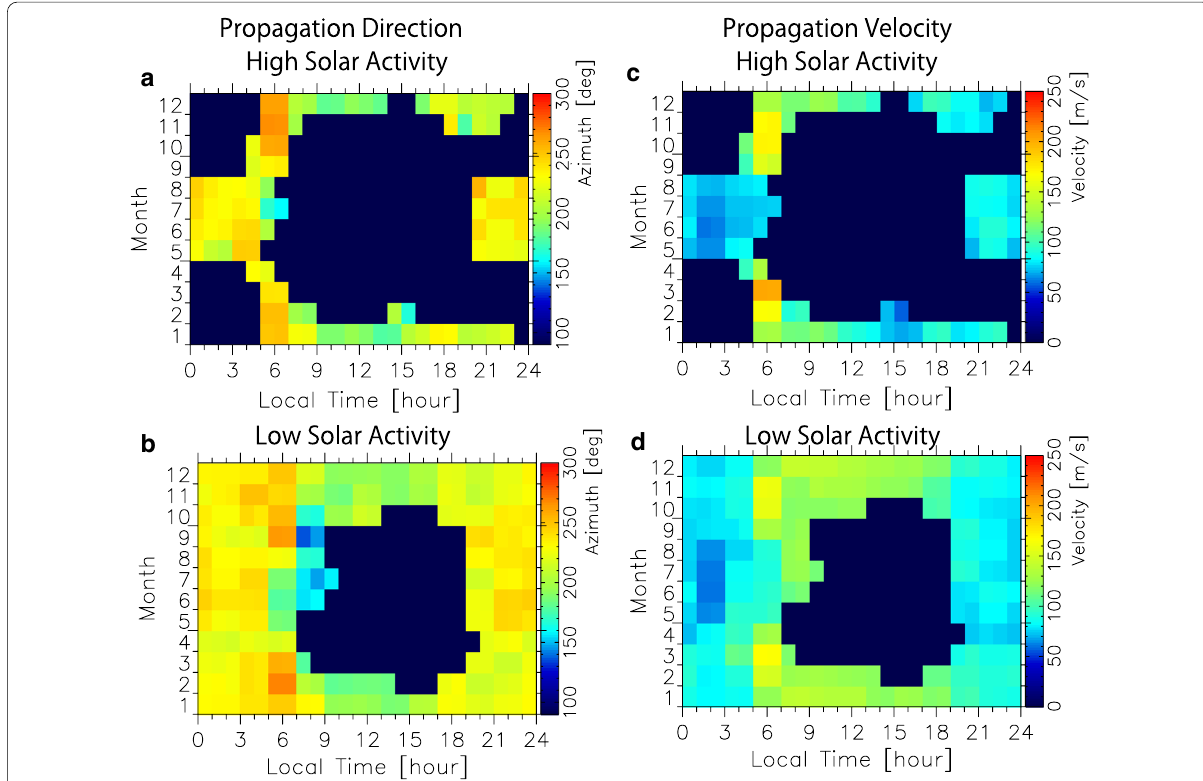
Fig. 5 Local time and seasonal variations of a, b horizontal propagation direction and c , d velocity of MSTID in the area of 133.0°–137.0° E and 33.0°–37.0° N under high and low solar activity conditions. Black indicates missing data. The data are shown only when the MSTID occurrence rate